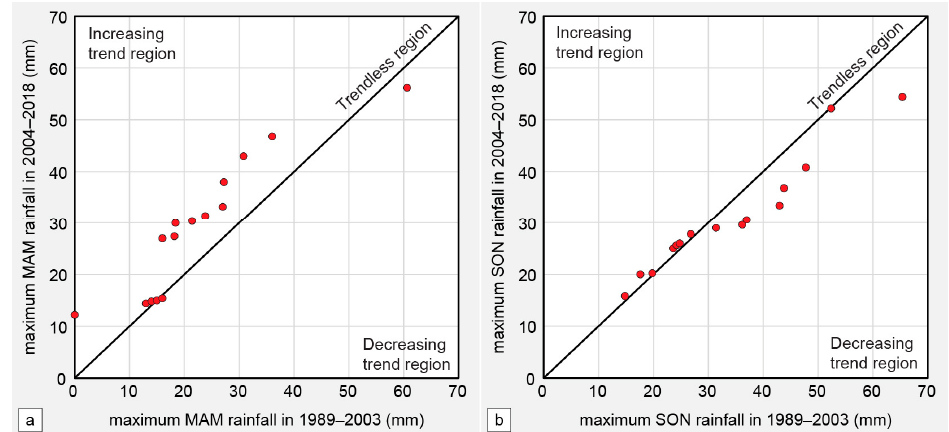
Figure 2. Results of the ITA test applied to the series of seasonal maxima recorded by the Potenza station, for the ( a ) March–April–May (MAM) and ( b ) September–October–November (SON) seasons.